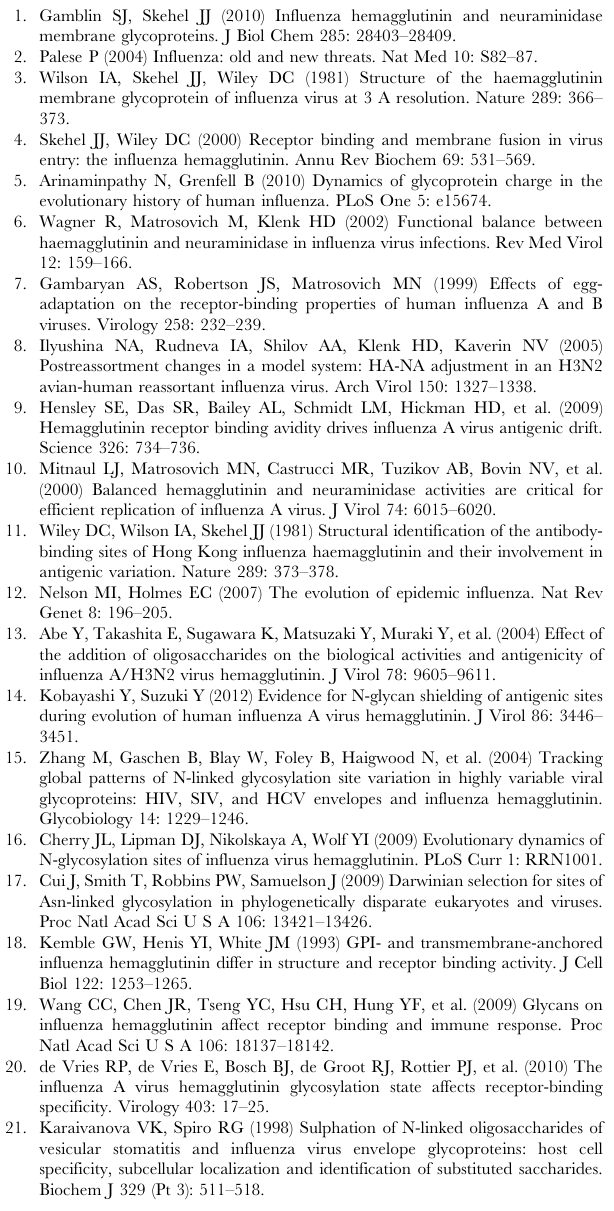
Table S2 Numbers of NGS + , NGS 2 , and NGS ± substi- tutions in HA1 on NGS ± branches in part I and II of the phylogenetic tree for A/H3N2 virus. a Charge + , charge 2 , and charge 6 denote the amino acid substitutions increasing, decreasing, and maintaining the positive charge of HA1, respectively. b The phylogenetic tree for A/H3N2 virus was divided into part I and II as shown in Figure S1. Amino